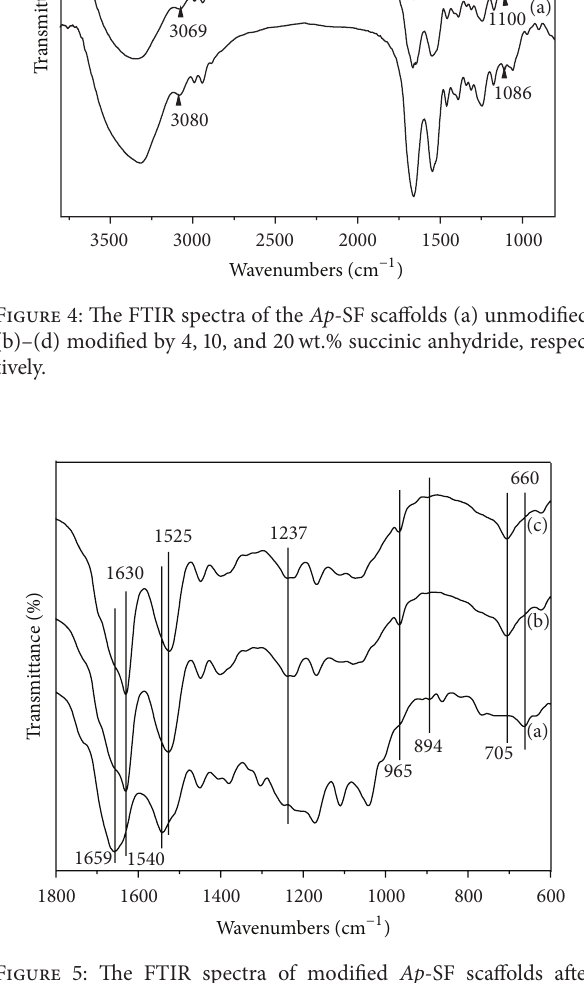
Figure 5: The FTIR spectra of modified Ap -SF scaffolds after enzymatic degradation for (a) 0 day; (b) 6 days; (c) 18